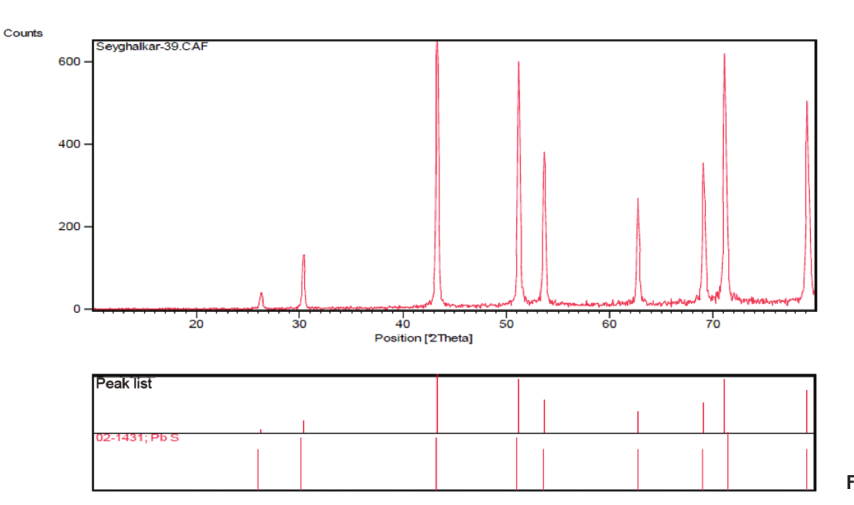
Figure 3: XRD pattern of sample no. 3.